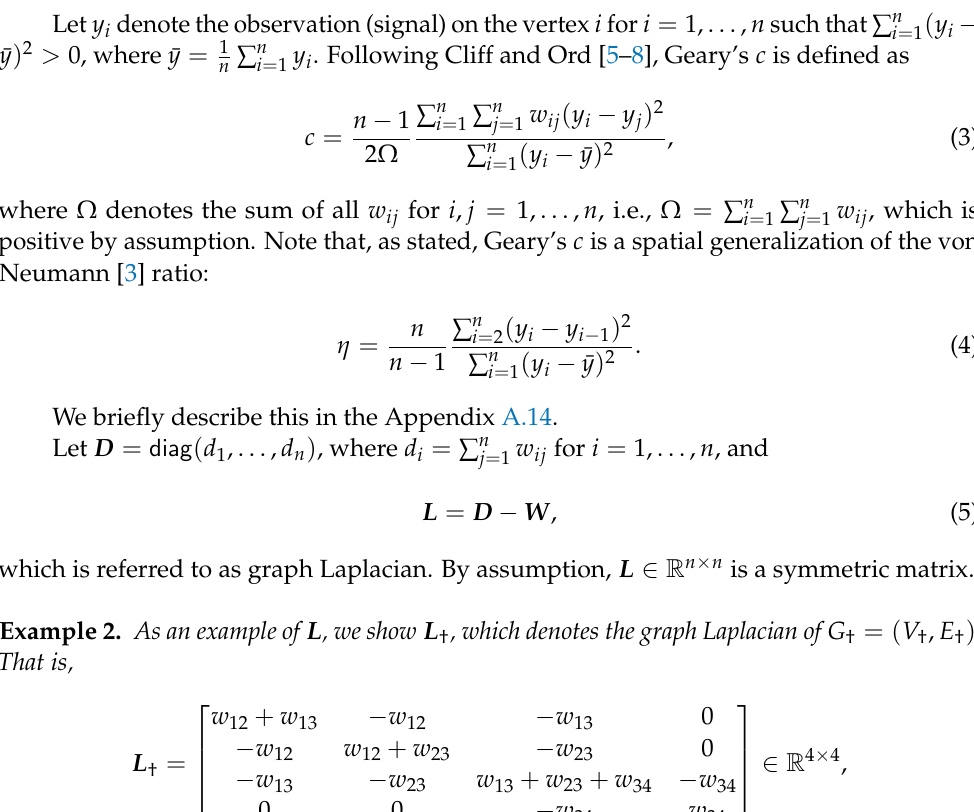
Figure 1. An undirected graph with four